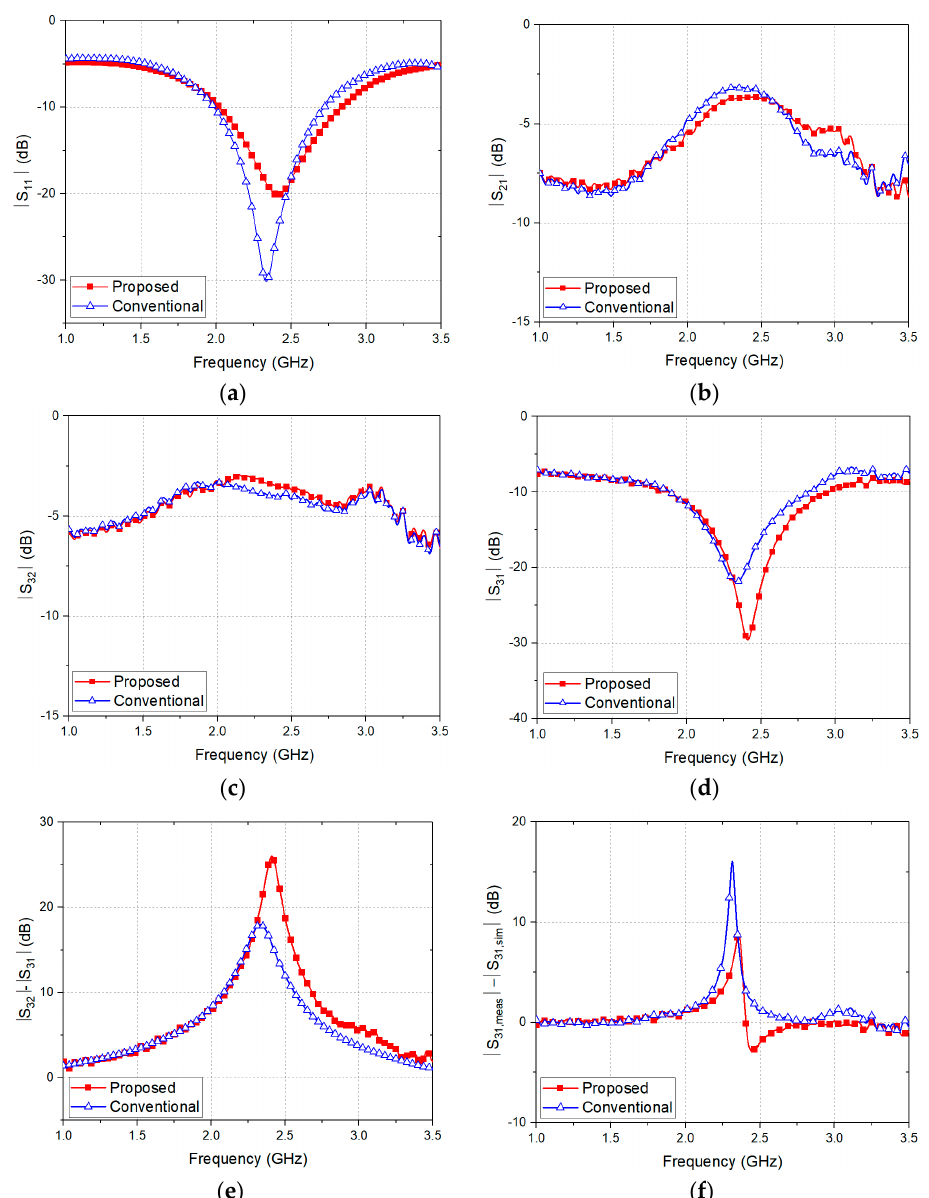
Figure 8. Measured S -parameters of the proposed and conventional quasi-circulators at 2.45 GHz: ( a ) | S 11 |; ( b ) | S 21 |; ( c ) | S 32 |; ( d ) | S 31 |; ( e ) | S 32 | − | S 31 |; ( f ) the difference of | S 31 | between the simulation and the measurement.